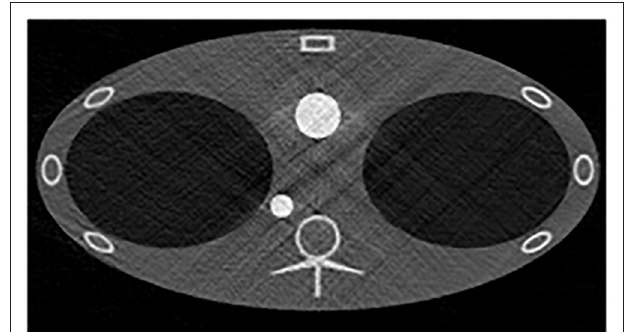
FIGURE 11 | The 110 kV low-energy scatter-free-full-view reconstruction results without TV constraints. The display window is [ − 1000, 2000] HU.